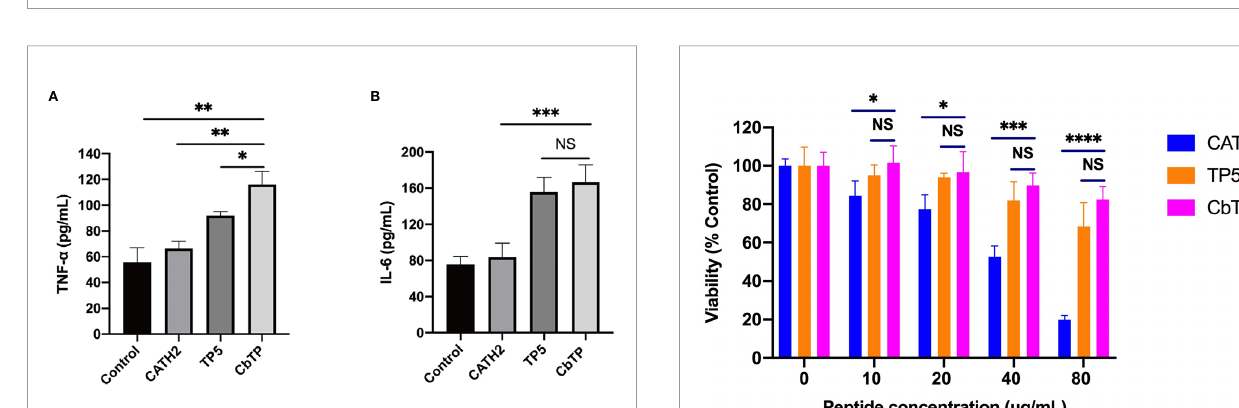
FIGURE 2 | The in vitro immunomodulatory activity of the hybrid peptides in RAW264.7 cells. After administration of 10 m g/mL peptides for 12 h, the protein levels of TNF- a (A) , IL-6 (B) and IL-1 b (C) in the RAW264.7 cell culture supernatant were quanti fi ed by ELISA. Statistical comparisons were performed by Student ’ s t test. The data are given as the mean ± standard deviation (n=5). NS: p > 0.05; *p ≤ 0.05; and **p ≤ 0.01.